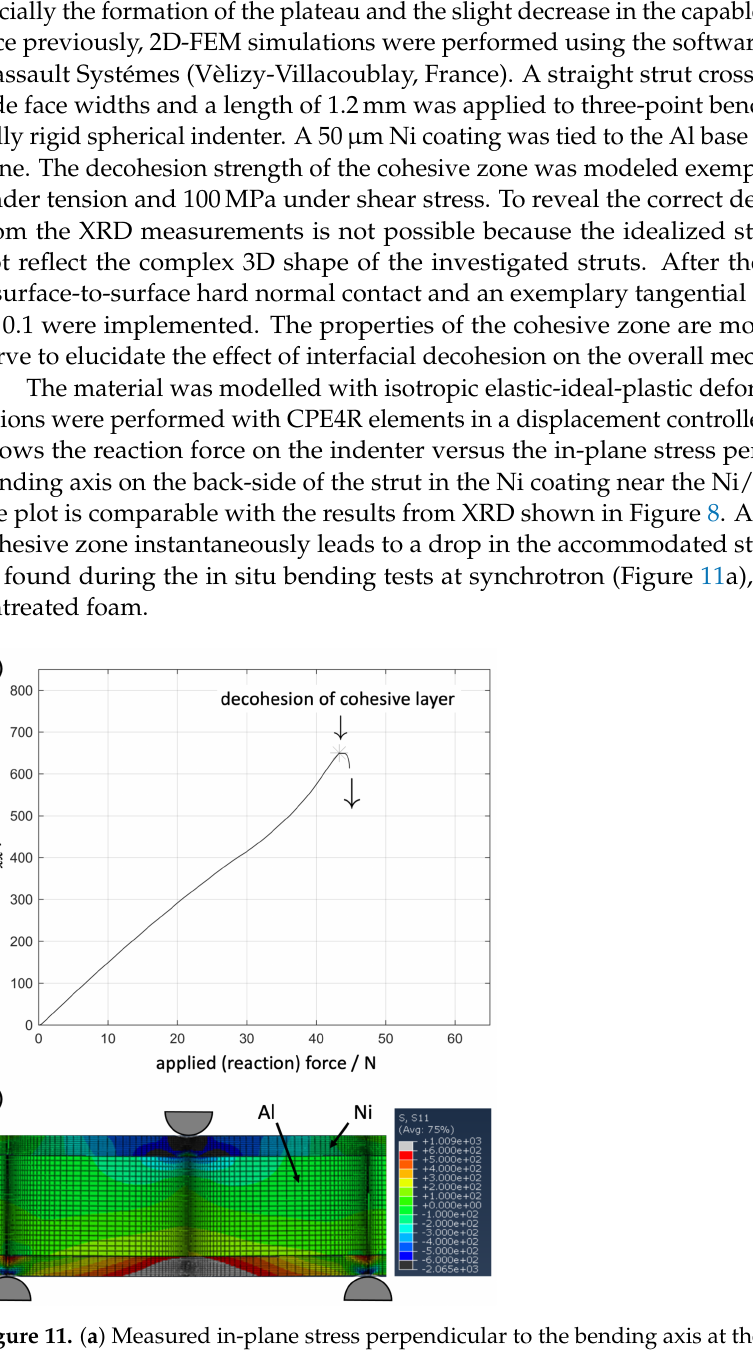
Figure 11. ( a ) Measured in-plane stress perpendicular to the bending axis at the Ni/Al interface vs. applied force (reaction force) from 2D FEM simulation, the moment of the decohesion of the interface modelled by a cohesive zone interlayer is marked ( b ) distribution of the in-plane stress perpendicular to the bending axis (limits+/ −